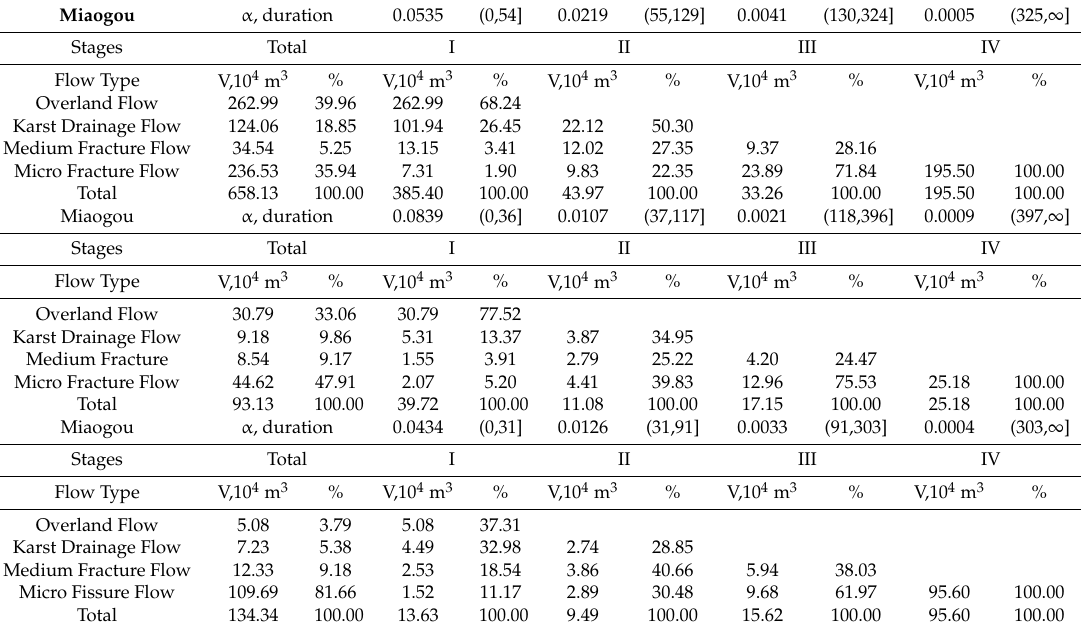
Table 4. Table of streamflow component separation for Miaogou watershed.